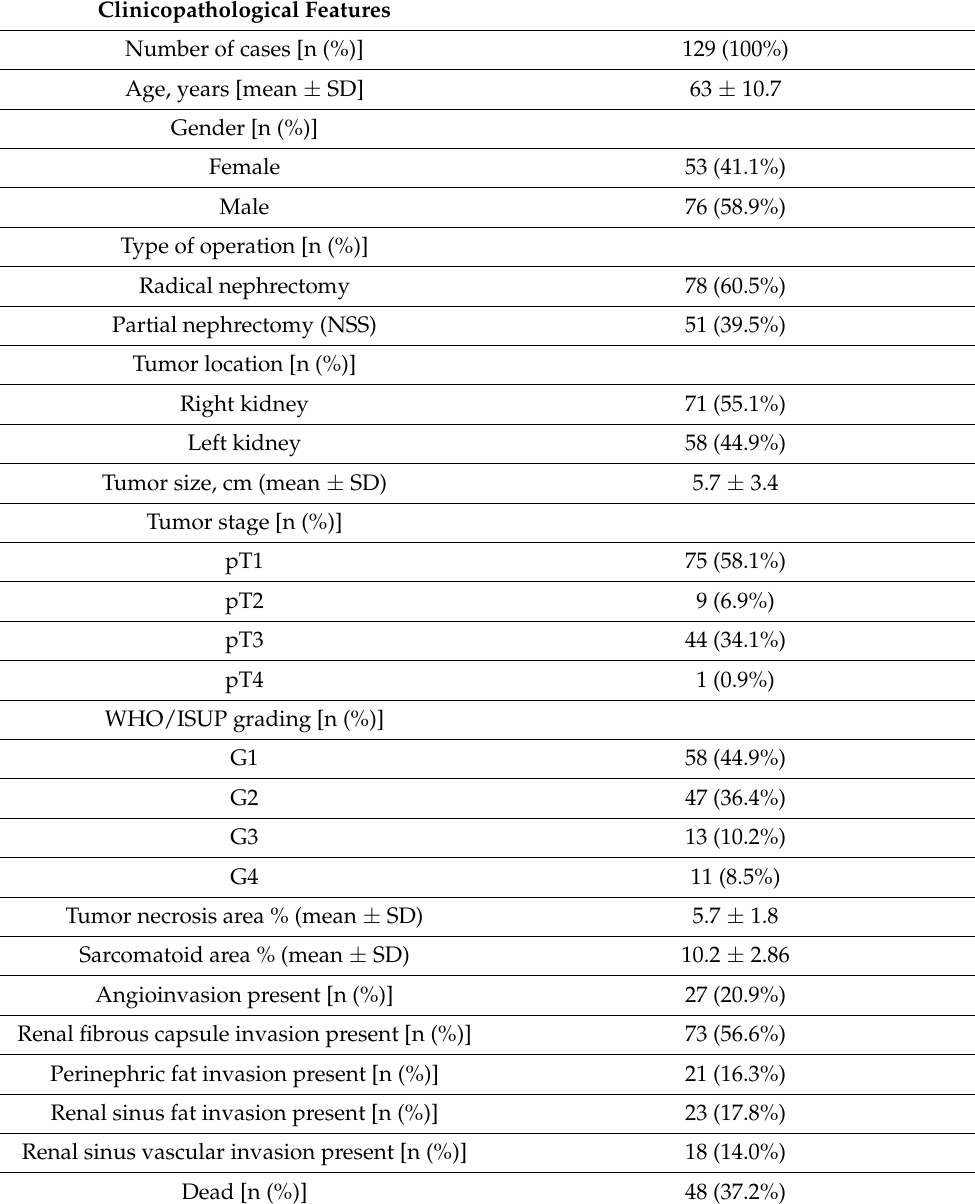
Table 1. Clinicopathological characteristics of patients.